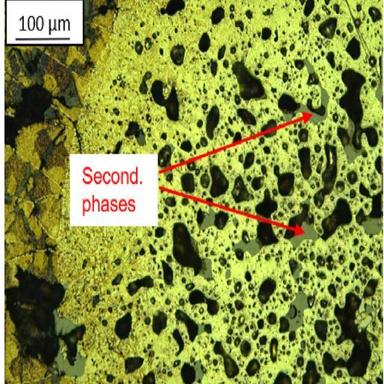
High magnification optical image of the central region from 501-G591, showing also the secondary phases inferred to be precipitates of rare earths and Am/ Cm.